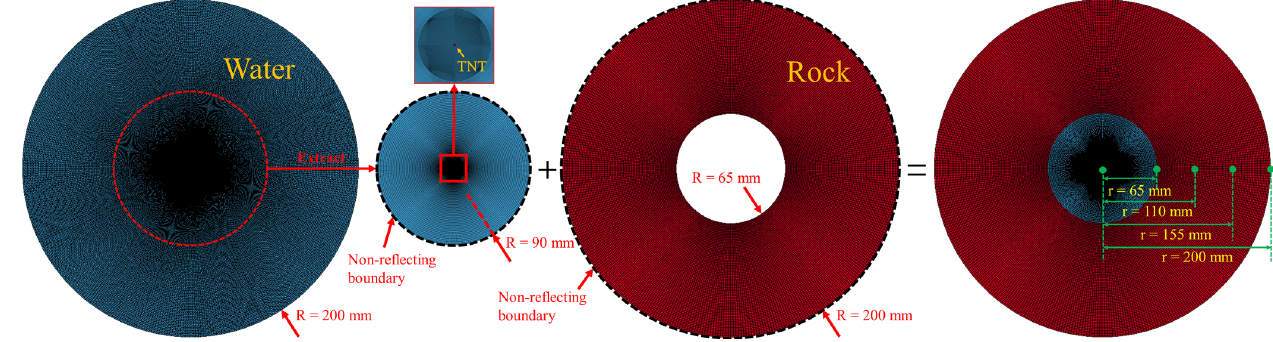
Figure 9. The coupled numerical model.